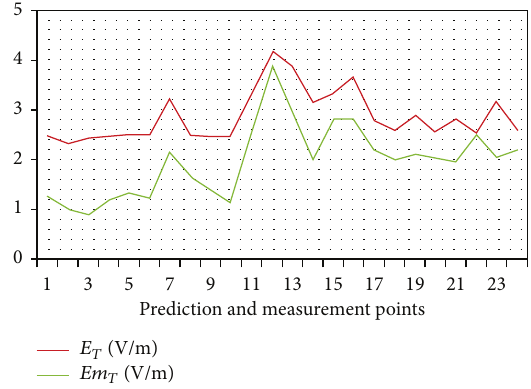
Figure 7: The diagram of 24 points with maximum values.